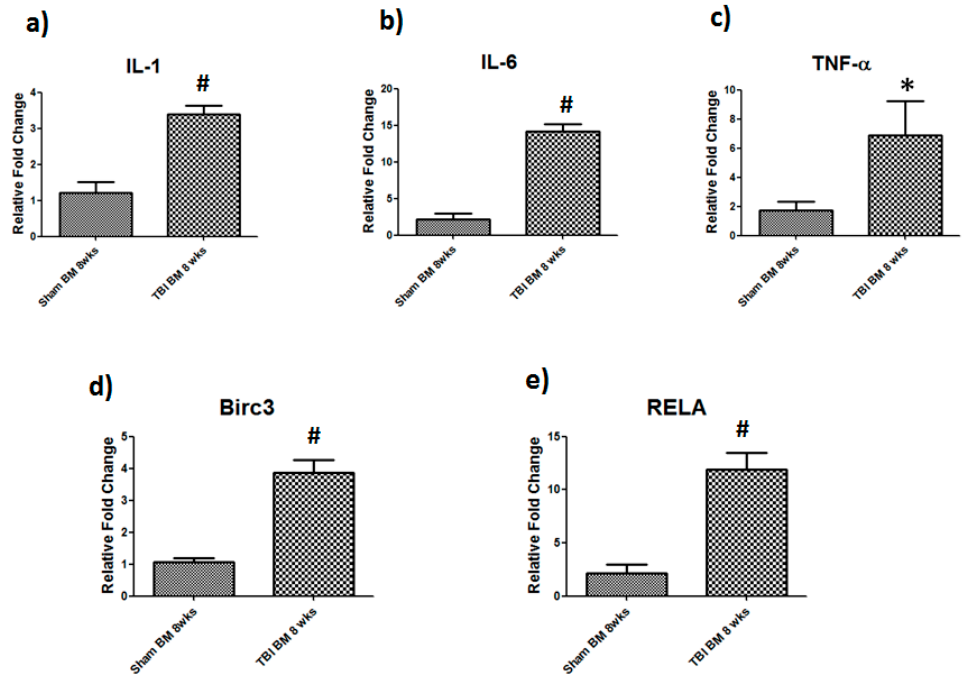
Figure 4. Elevated level of inflammatory and NF-kB signaling genes in TBI bone marrow. TBI mice showed increased mRNA expression of inflammatory genes ( a ) IL-1, ( b ) IL-6, ( c ) TNF- α and NF-kB signaling genes ( d ) Birc3 ( e ) RelA/p65 in 8-week TBI bone marrow. After reverse transcription of total RNA, cDNA was amplified by quantitative real-time PCR. Data for each sample were normalized with GAPDH mRNA represented as the fold change in expression compared to sham mouse. Results are means ± SD ( n = 6), Significant * p < 0.05, and # p < 0.01 determined by using student’s t -test.